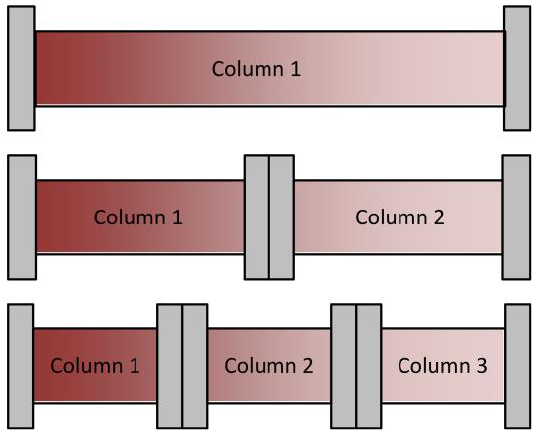
Figure 3. Schematic overview of column capacity utilization for different numbers of columns in the loading zone.